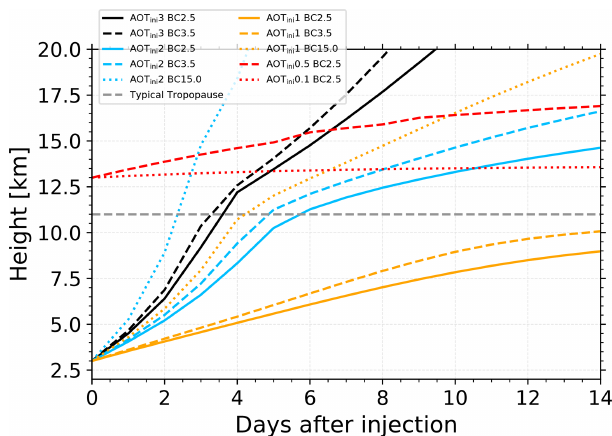
Figure 11. Change in the center height of a 2.5km thick aerosol layer, initially at 3km height (day 0), during 14d of continuous lofting (black, blue, orange). In the simulation, the AOT continu- ously decreases by 15% from day to day. Different scenarios with different initial AOT of 1, 2, and 3 (indicated by index ini) and BC fraction of 2.5%, 3.5%, and 15% are simulated. In addition, the lofting behavior of a stratospheric layer initially at 13km height (red lines; see legend regarding AOT and BC fraction; 15% AOT decrease from day to day) is shown. The dashed gray line repre- sents a typical tropopause height in the